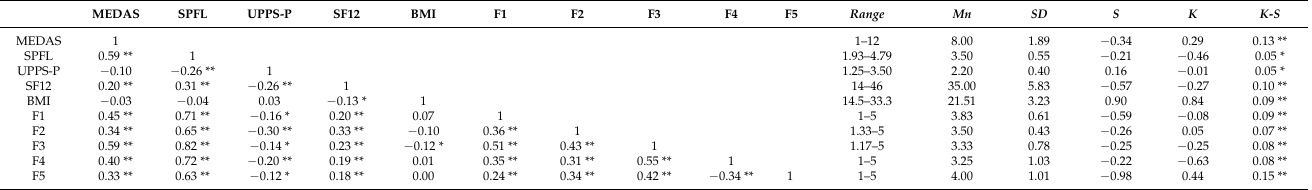
Table 3. Correlations (Spearman) between the Mediterranean diet adherence screener (MEDAS) with the total score of the self-perceived food literacy (SPFL), the impulsivity (UPPS-P short version), the self-perceived health questionnaire (SF12), and the five factors of food literacy (F1 = cooking skills; F2 = emotional management; F3 = healthy consumption as a priority; F4 = nutritional literacy and planning; F5 = availability of ultra-processed foods). Data are presented as: Mn = median, SD = standard deviation, S = Skewness; K = Kurtosis; K - S =